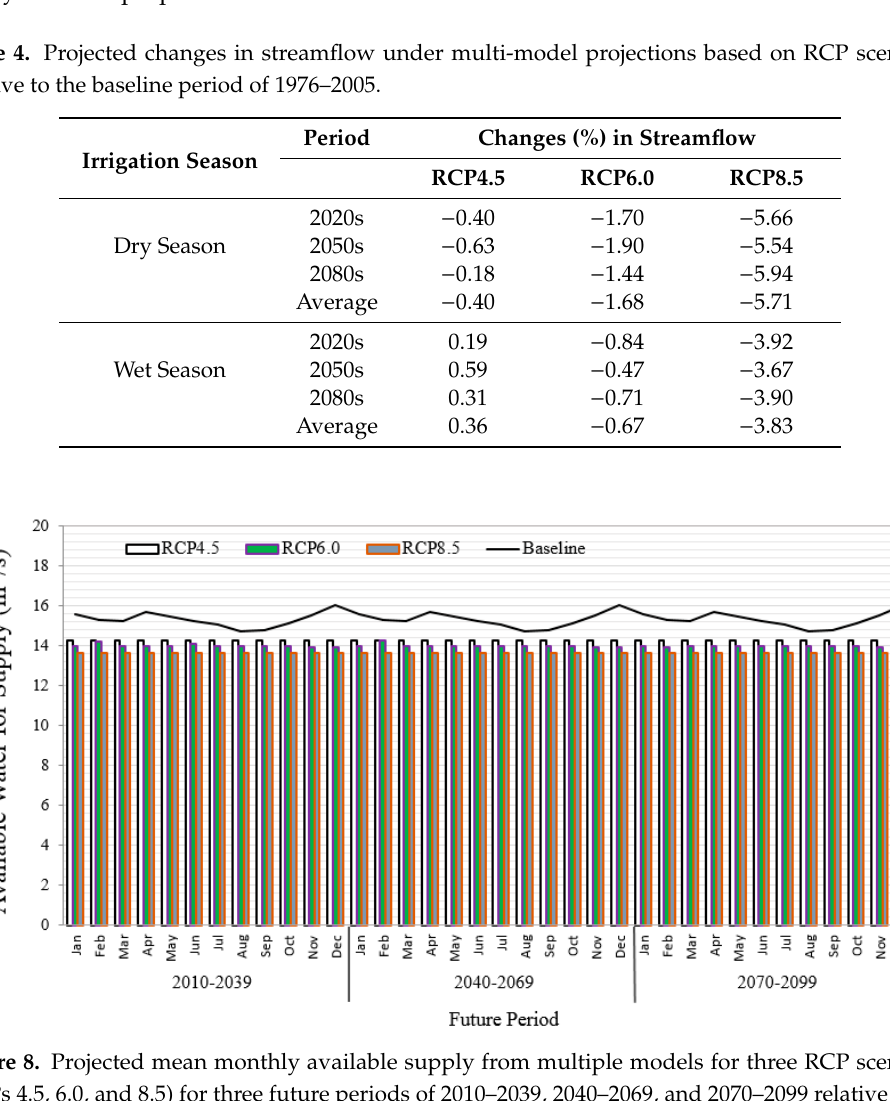
Figure 8. Projected mean monthly available supply from multiple models for three RCP scenarios (RCPs 4.5, 6.0, and 8.5) for three future periods of 2010–2039, 2040–2069, and 2070–2099 relative to